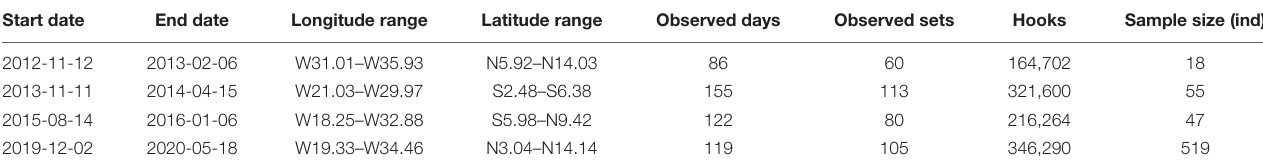
TABLE 1 | Observer reports on the Tropical Eastern Atlantic longline fishing trips.